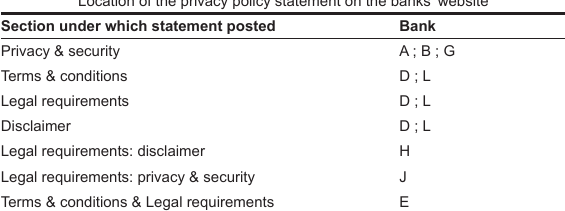
TABLE 3 Location of the privacy policy statement on the banks’